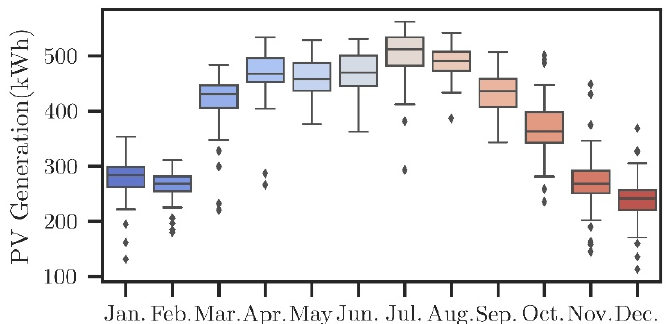
Figure 3. PV generation per household; the PV capacity of all analyzed households is 3 kWp (n = 55).